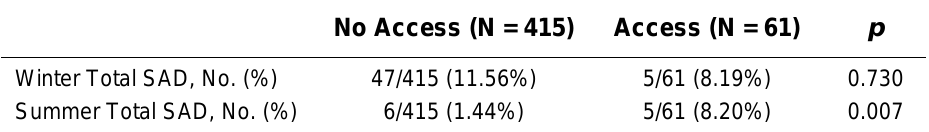
Winter and Summer Total SAD and Accessibility to Air